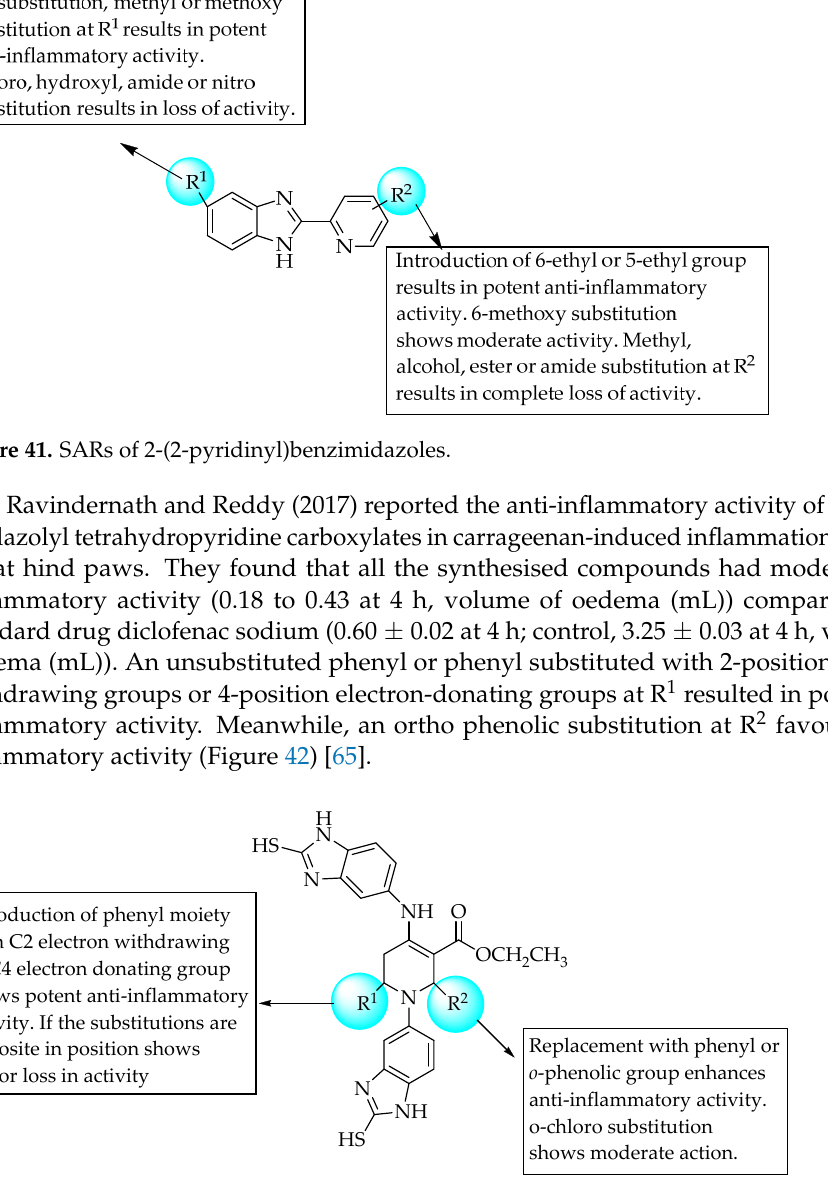
Figure 42. SARs of benzo[d]imidazolyl tetrahydropyridine carboxylates. In another study, a fused pyrimido[1,2-a]benzimidazole with phenylsulfonyl moiety was evaluated for its effect on anti-inflammatory activity. A compound with a fused pyrimido ring exhibited less anti-inflammatory activity than indomethacin (Figure 43) [66]. Both electropositive and negative groups at the phenyl group, which is directly connected to the fused pyrimido moiety, were tested.